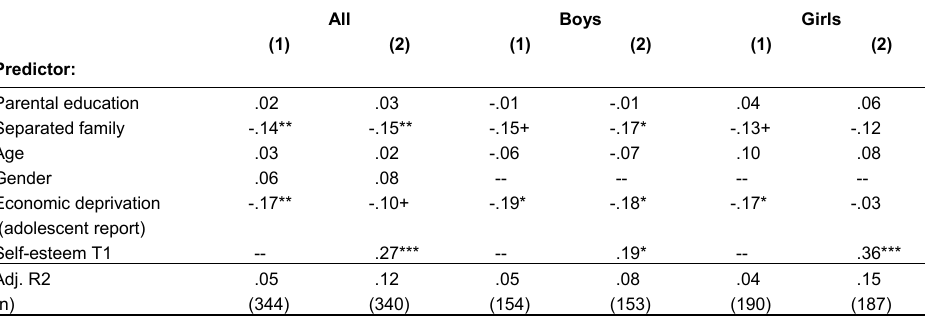
Table 4 : Effects of economic deprivation on offspring self-esteem six years later